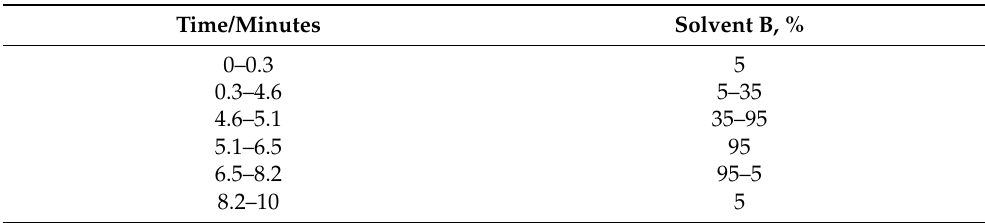
Table 5. Gradient elution